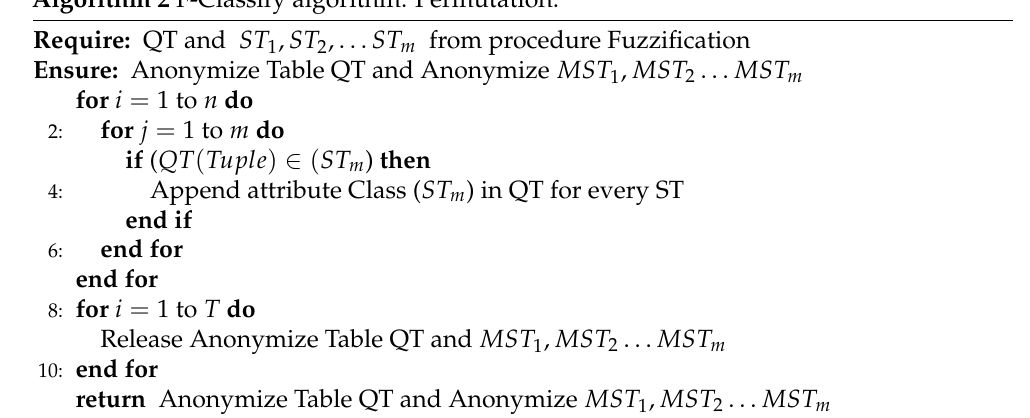
Algorithm 2 F-Classify algorithm: Permutation.